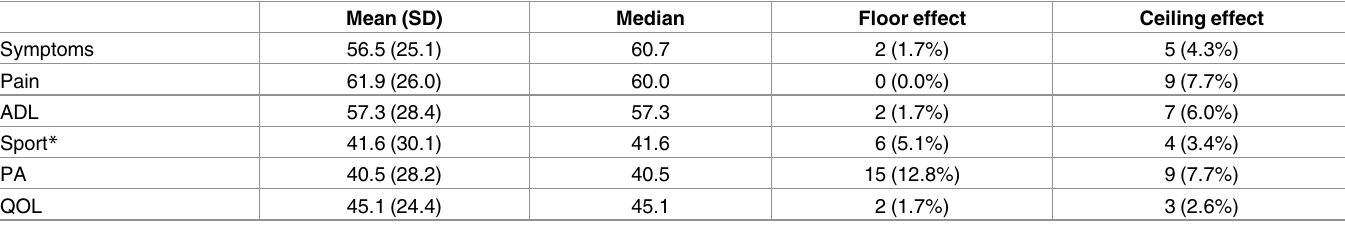
Table 6. Frequency of the minimum and maximum scores on the HAGOS-NL (N = 117). Mean